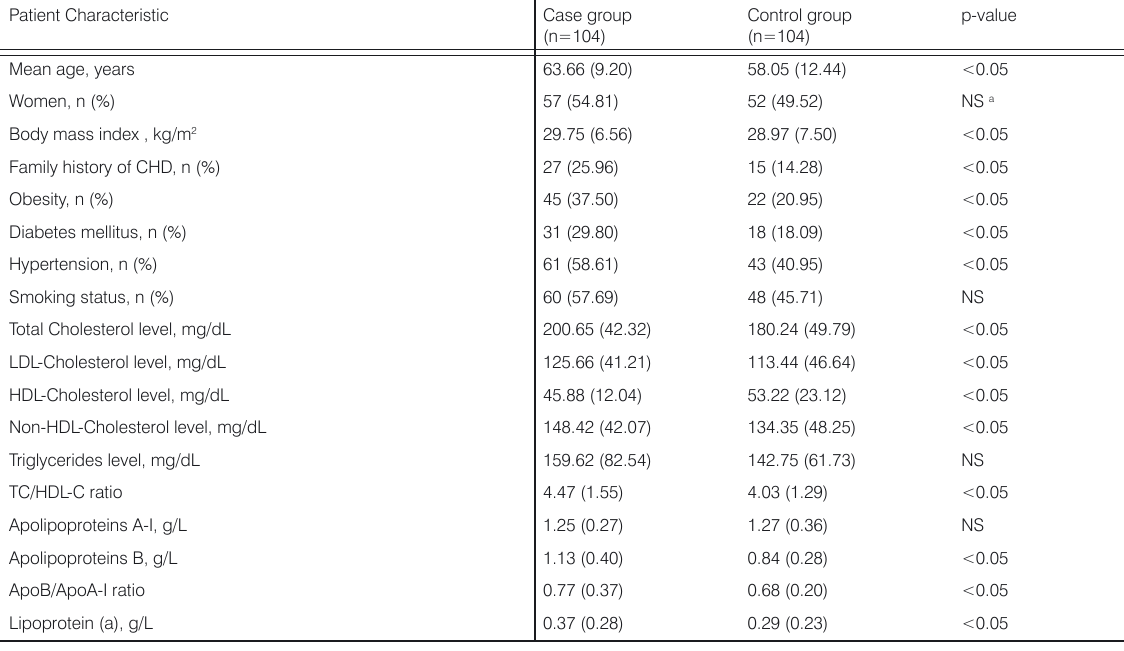
Table 1. Characteristics of study